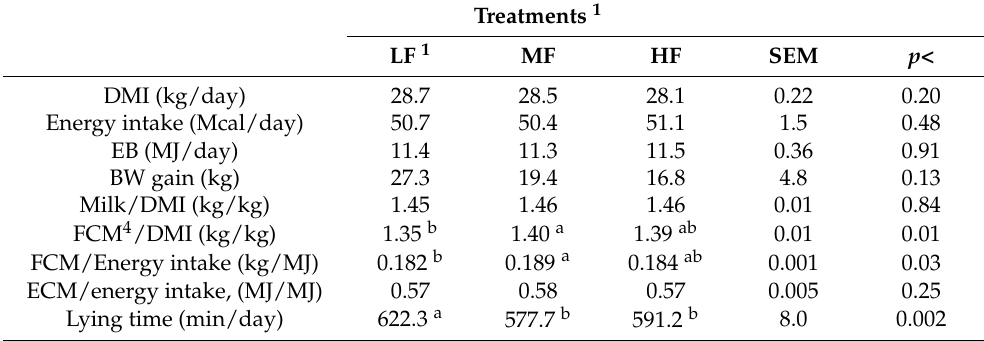
Table 3. Least squares means of dry matter intake, energy balance, and efficiency calculations.